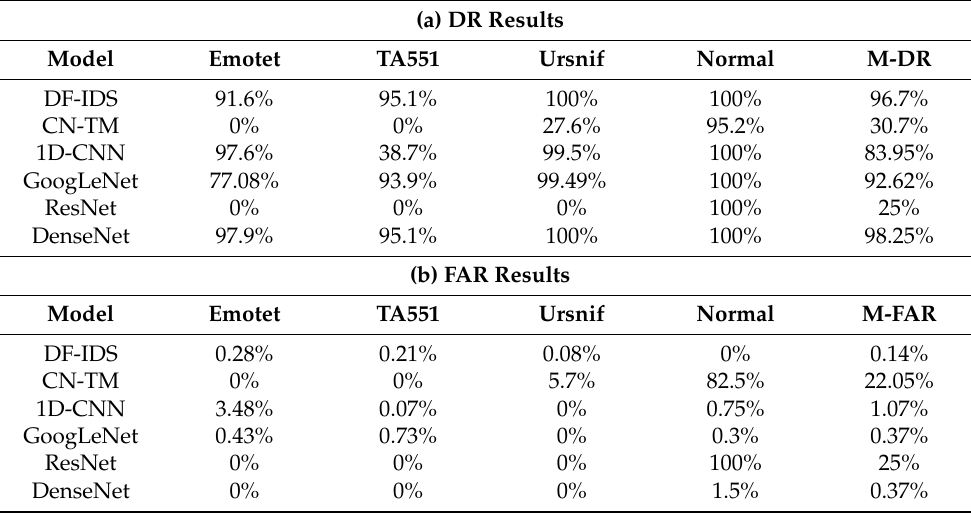
Table 12. Performance of multiclassification model using Dataset